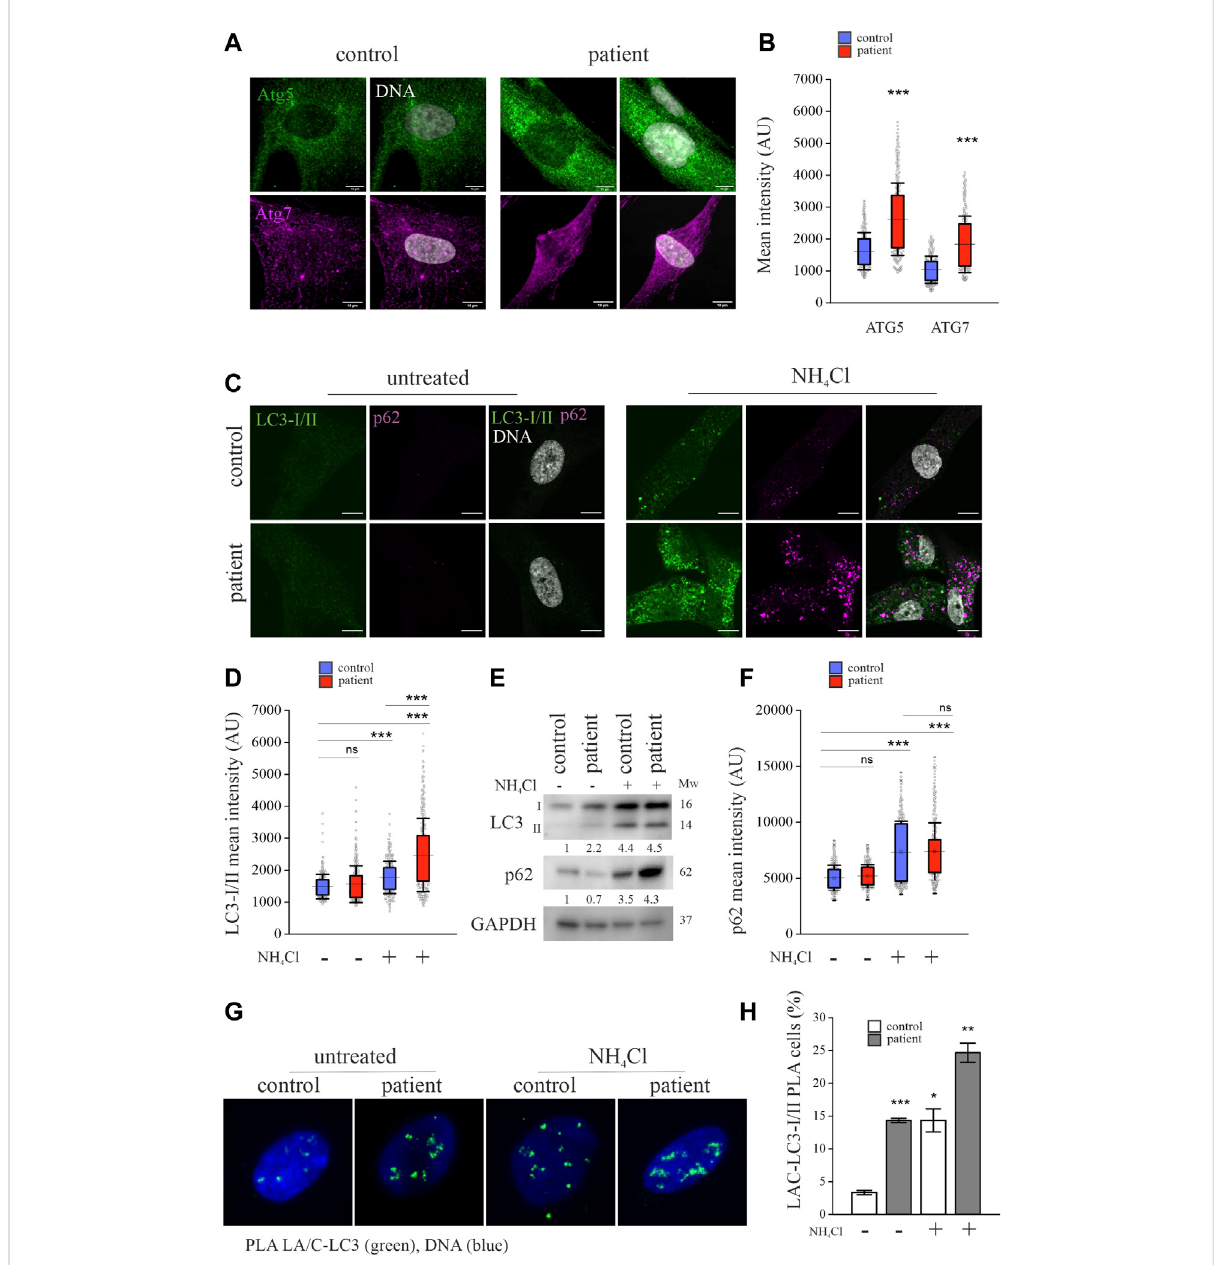
FIGURE 3 LaminsA andC areincreasinglycommitted to autophagyin LMNA mutantpatient fi broblasts. (A) Confocal microscopy images fromthepatient and control fi broblasts stained for autophagy-related proteins Atg5 and Atg7. Scale bar 10 µm. (B) Calculated mean fl uorescence intensity values from Atg5 and Atg7 stainings. The whiskers show mean values ± s.d and boxplots show the 75th and 25th percentiles (N = 300), *** p < 0.001. (C) Confocalmicroscopyimagesfromthepatientandcontrol fi broblaststreatedwithorwithout20mMNH 4 Clfor24handstainedforAtg8/LC3-I/ II and SQSTM1/p62. Note the accumulation of LC3-I/II or p62 after NH 4 Cl treatment especially in the patient cells. Scale bar 10 µm. (D) Calculated mean fl uorescence intensity values from LC3-I/II staining. The whiskers show mean values ± s.d and boxplots show the 75th and 25th percentiles (N = 300), *** p < 0.001 (compared to untreated control cells). (E) Western blot analysis from control and patient fi broblasts treated with 20 mM NH 4 Cl for 24 h. Pooled LC3-I/II and p62 levels were normalized to GAPDH, which was used as a loading control. Note the increase of LC3-II after NH 4 Cl treatment. (F) Calculated mean fl uorescence intensity values from p62 staining. (N = 300), *** p < 0.001 (G – H) Proximity ligation assay (PLA) detecting association of lamins A and C with LC3-I/II in the control and patient fi broblasts. The percentage of cells with PLA signals was determined from > 300 cells and the cells with more than three PLA signals were considered positive. Data is expressed as mean ± s.e.m, * p < 0.05, ** p < 0.01, *** p <